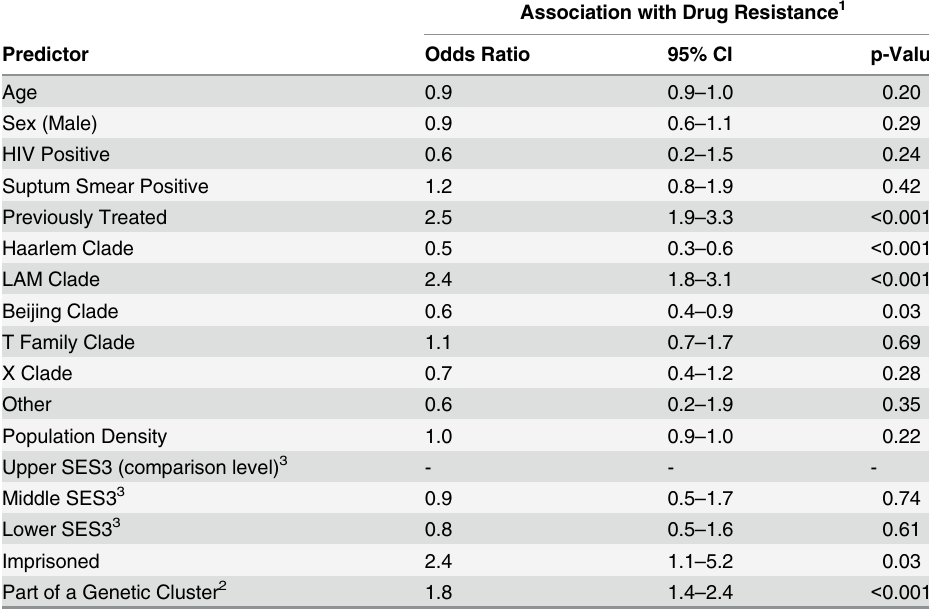
Table 2. The Predictors of Drug Resistance (multivariate logistic regression